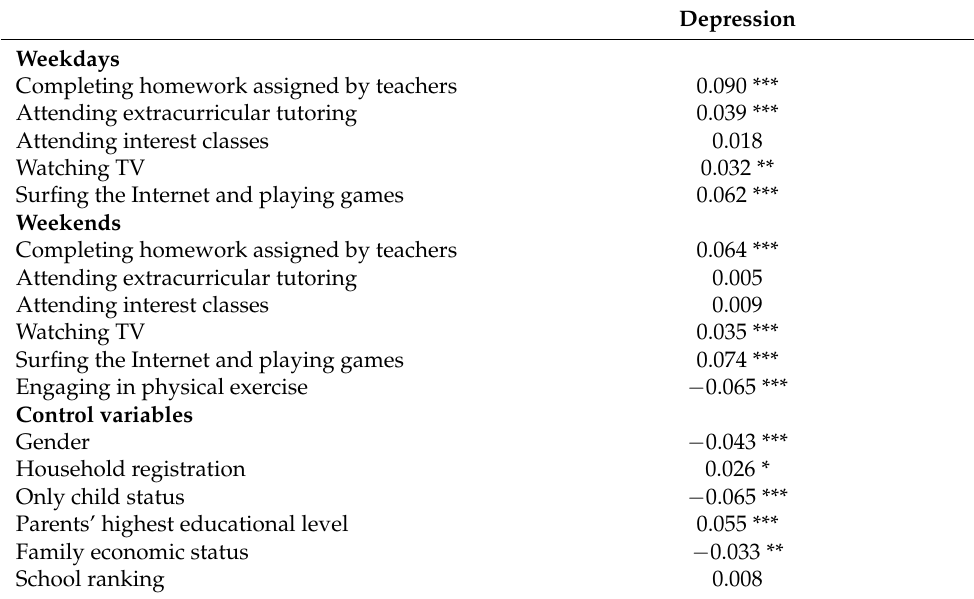
Table 2. Correlation between extracurricular activities and depressive